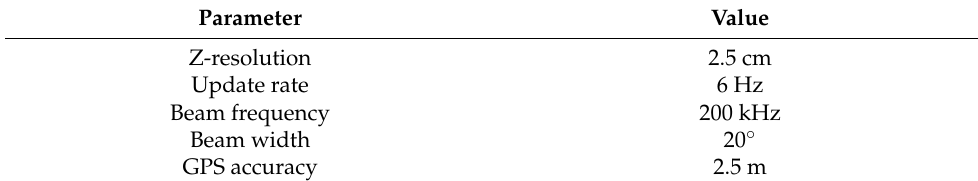
Table 2. Summary of the specifications of the sonar survey equipment used.